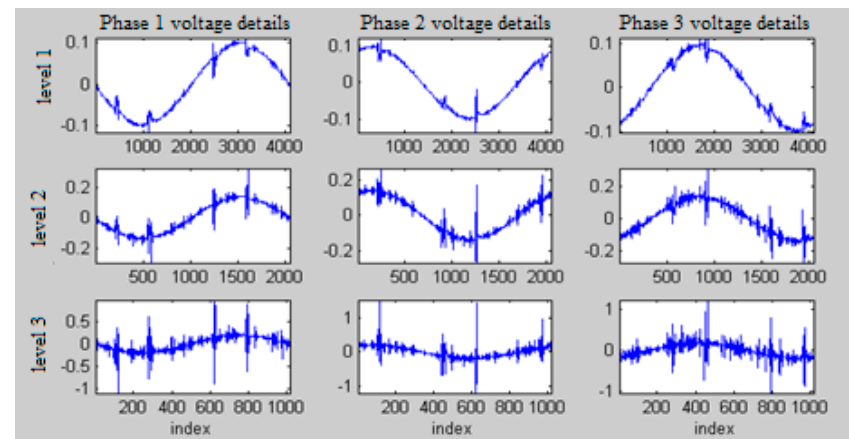
Figure 7. Vectors of details for voltages, levels 1–3, first case study.